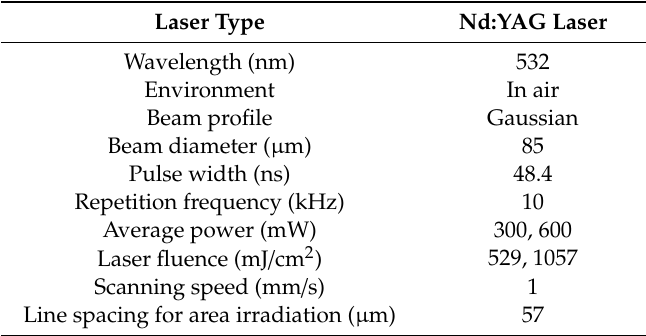
Table 1. Laser irradiation